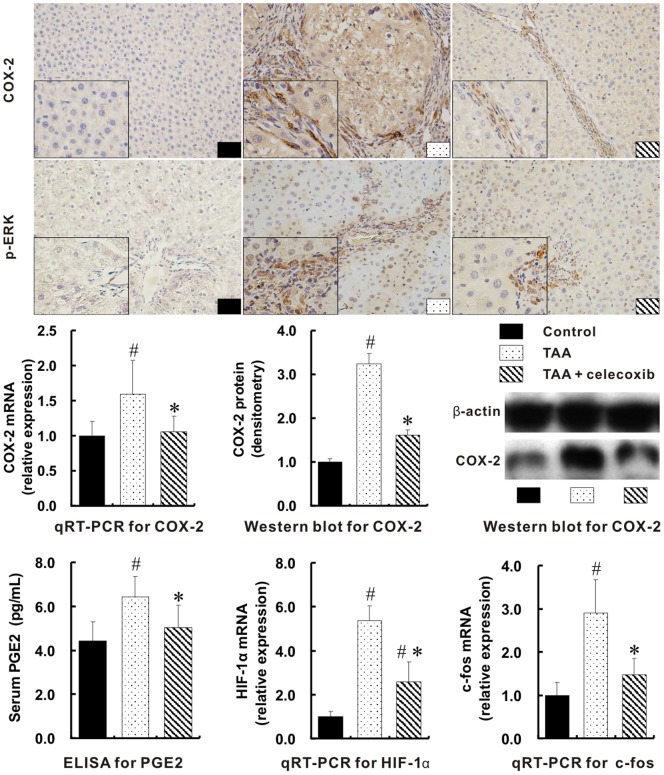
Suppression of the integrated signal pathways with celecoxib treatment.Much more positive expressions for COX-2 and p-ERK were visualized in TAA group (Immunohistochemical stain, ×400 magnifications; inserts, ×1000 magnifications). The mRNA and protein levels of hepatic COX-2 in TAA group measured with qRT-PCR and Western blot separately were the highest among three groups. The serum levels of PGE2 were measured by ELISA. The mRNAs for HIF-1α and c-fos were determined by qRT-PCR. # p<0.01 vs. control group; * p<0.01 vs. TAA group.